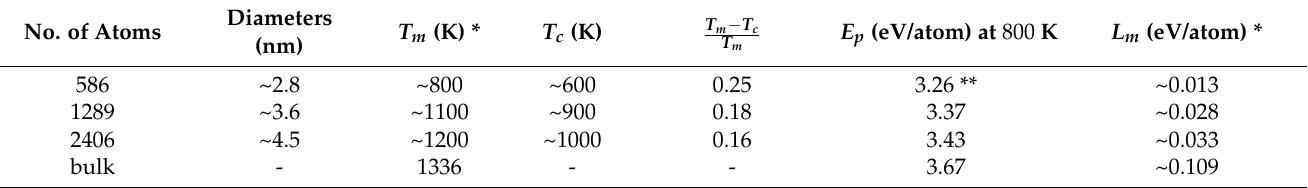
Table 1. Melting temperature ( T m ), coalescence temperature ( T c ), potential energy ( E p ) and latent heat ( L m ) of nanoparticles. * These values are approximations from computed simulation data points in Figure 2. ** The nanoparticle 586 is liquid at 800 K. 1 eV/atom = 96.45